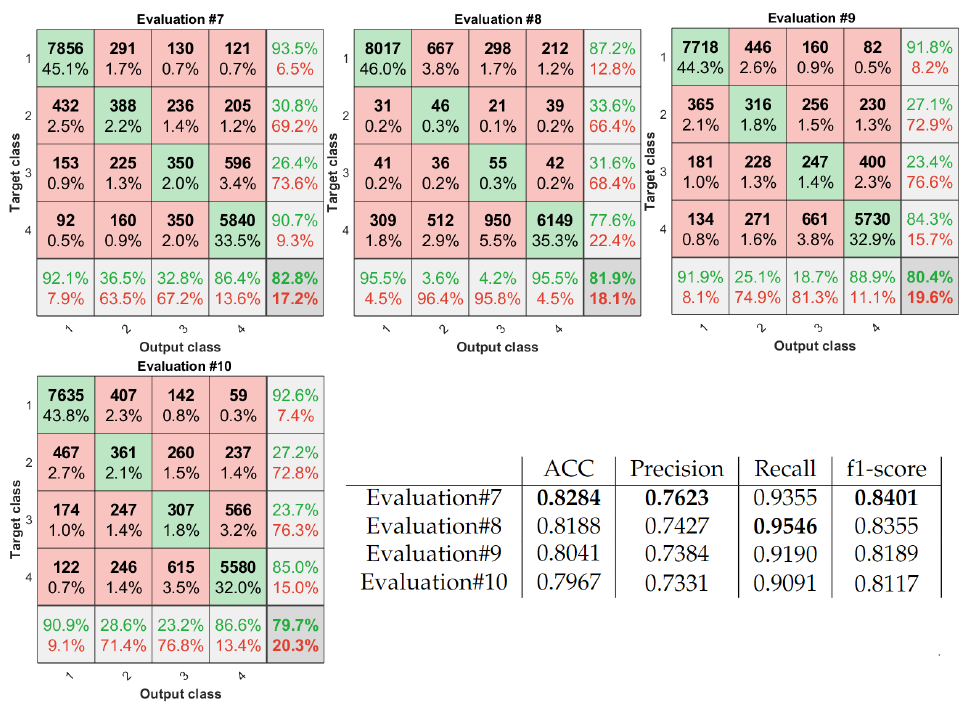
Figure 11. Confusion matrices and classification performance measures obtained for multi-class analysis. Table 4. Experts and algorithms agreement-unweighted Cohen’s kappa. Kappa Agreement